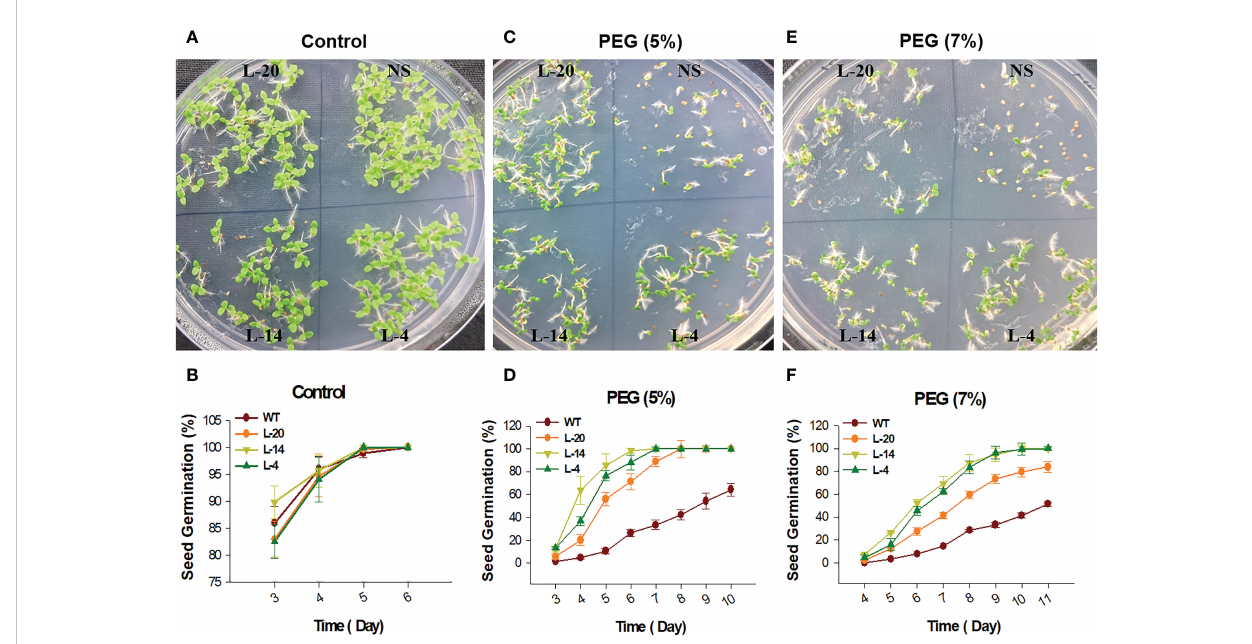
FIGURE 5 Seed germination analysis for PEG stresses tolerance; (A, C, E) Represents phenotypic difference during control, and PEG treatments, (B, D, F) germination percentage of NS and VaDJI transgenic lines under mock, 5% PEG and 7% PEG stress. Experiments were repeated with three technical and three biological repeats. Error bar depicts mean ± S.E. Statistical signi fi cance was tested using one-way analysis of variance (ANOVA) and *(single asterisk) indicates p ≤ 0.05.